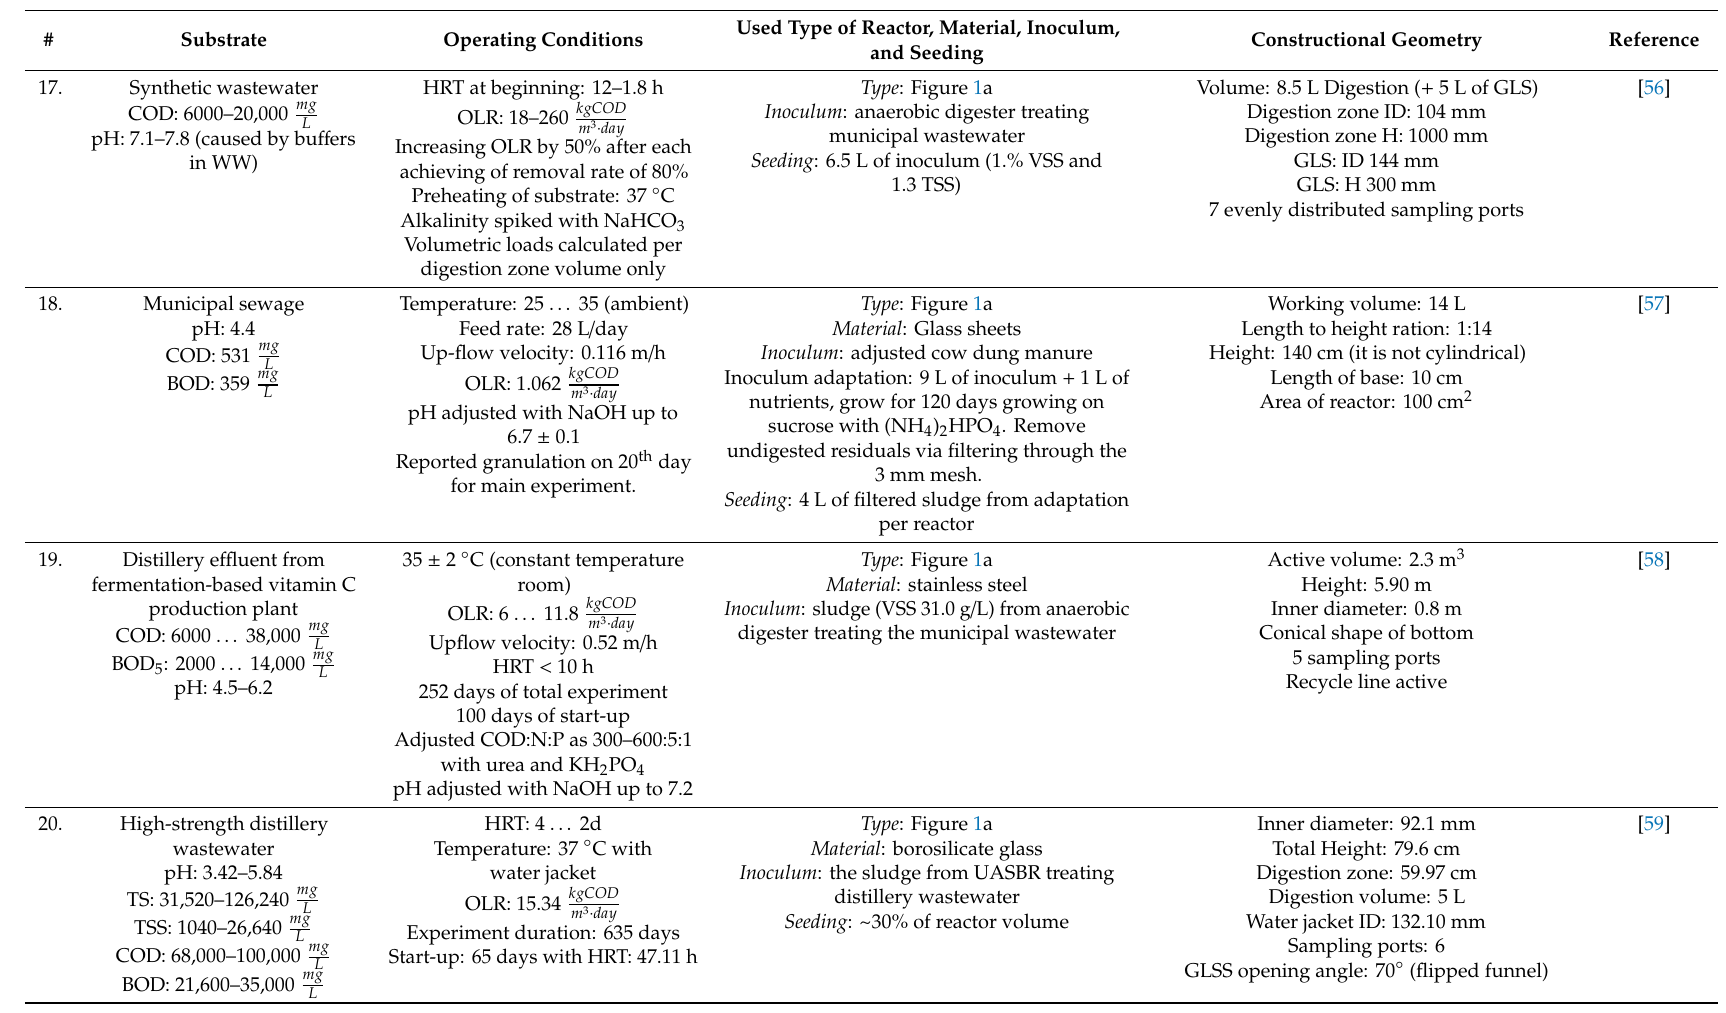
Type : Figure 1a Material : borosilicate